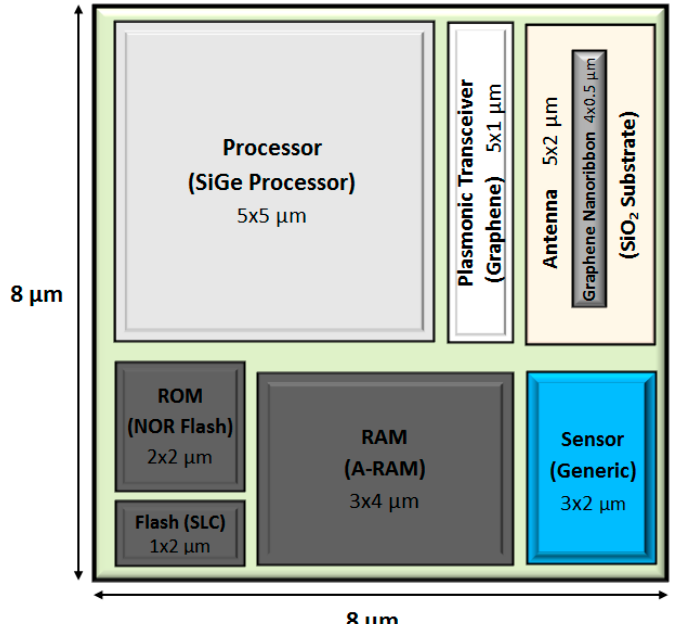
Figure 6. Nanodevice layout.